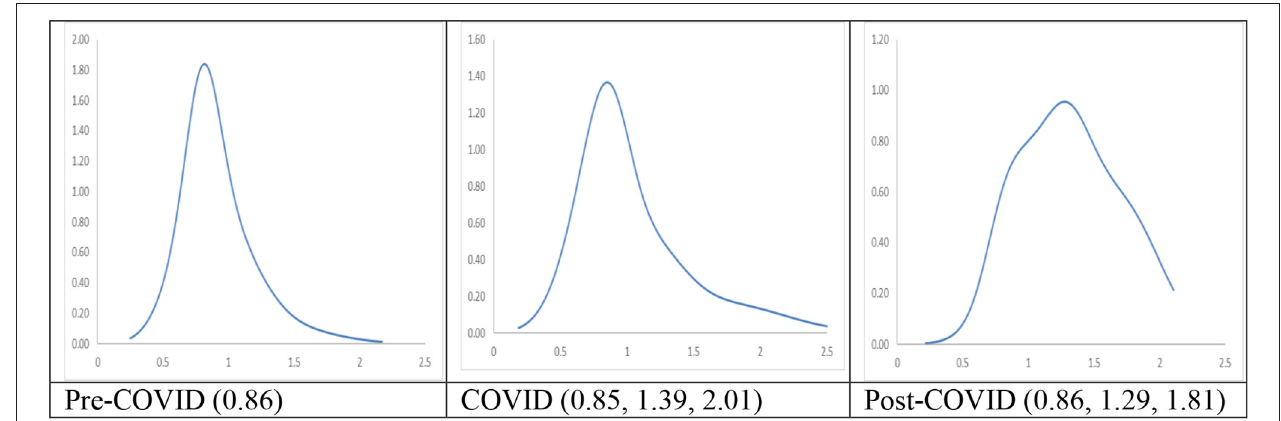
FIGURE 6 | Ergodic distributions for the RDIPC of all cities with medium duration of Level I ERS. Source: authors’ calculation. N.B. The vertical axis indicates the density of probability, the horizontal axis indicates RDIPC values, and the value of the peaks are in parentheses.